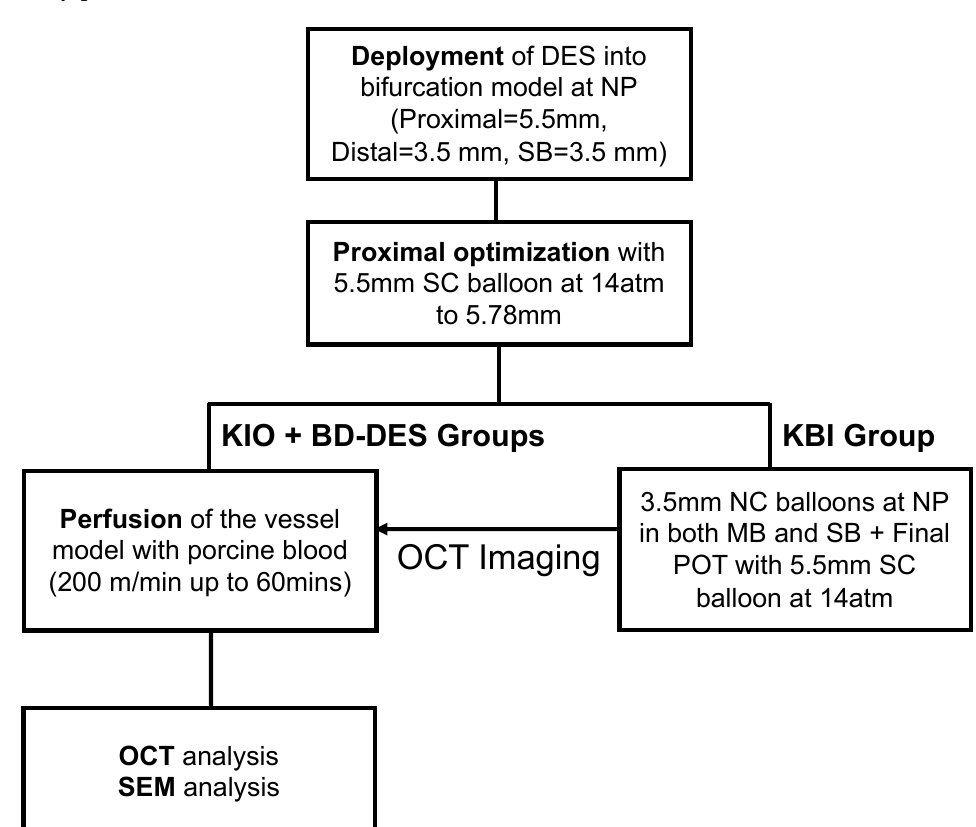
Figure 1. Optical images of platforms implanted into a model of bifurcation.